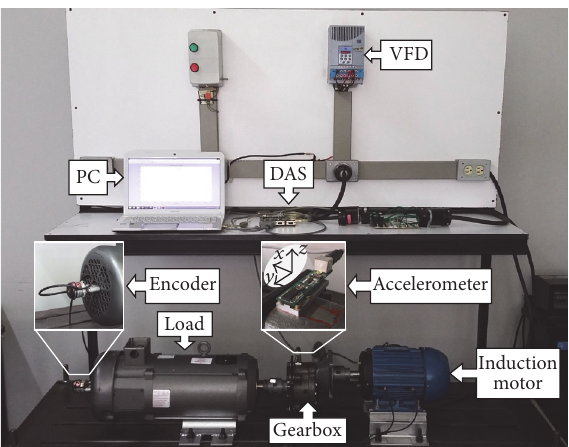
Figure 3: Test bench used for